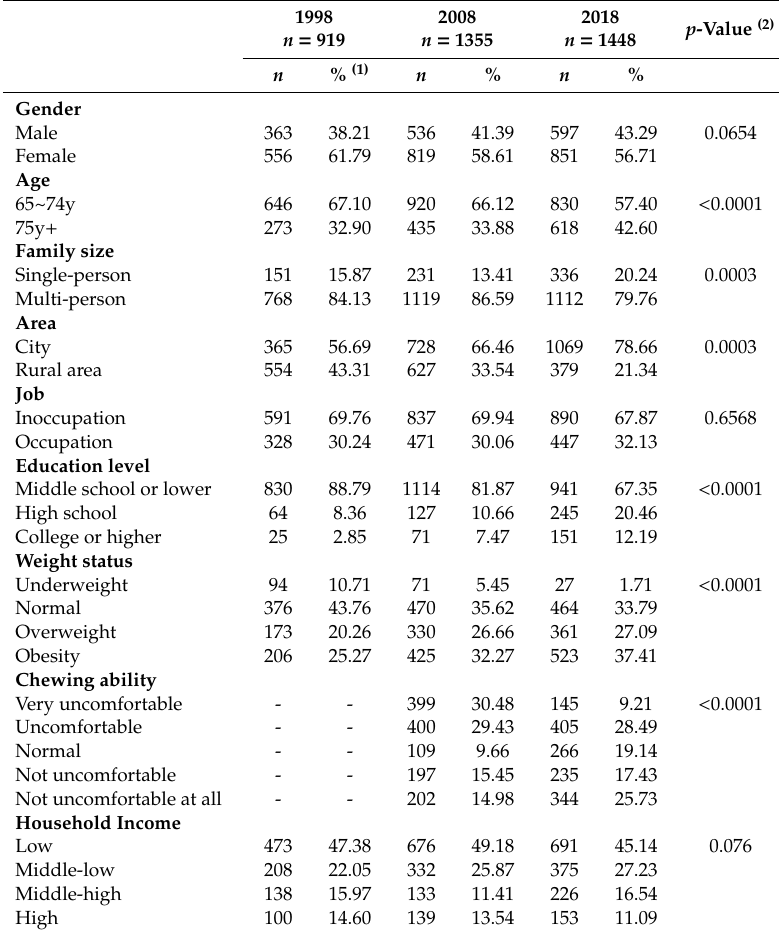
Table 2. General characteristics of subject sample by survey year.